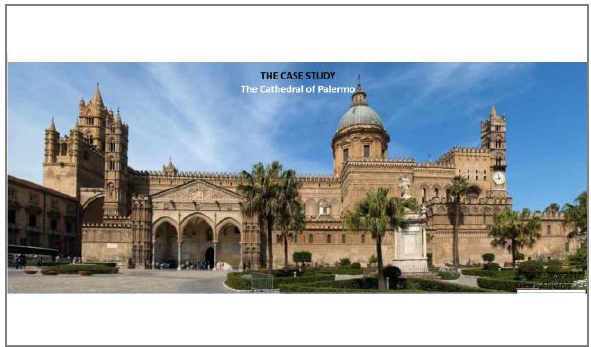
Figure 3. The case study: the Cathedral of Palermo Simulated flights were done in GE, trying to have more different oblique grades and levels of the ground. The GE video acquisition was performed using the Microsoft Expression 4 Screen Capture Software on a NVIDIA Quadro K1100M monitor, which delivered video images at a range of 3 to 4 magapixel (MP) resolution. This data set was been integrated with the other one made from ground floor with a Nikon 5200 at 24 MP. The SfM elaboration was made using Adobe Photoscan. To use two data set, with so big resolution distance, it is necessary to create two different chunks in Photoscan and align them with markers.